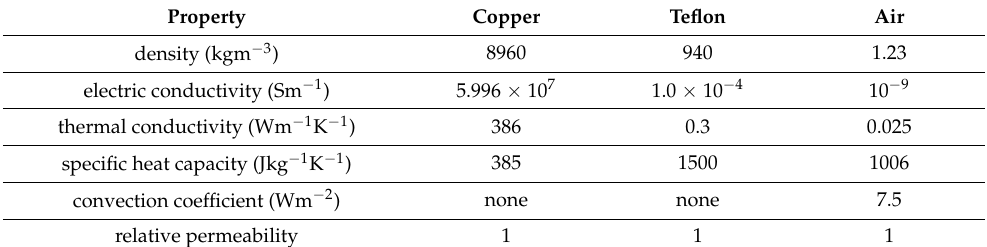
Table 1. Properties of materials.